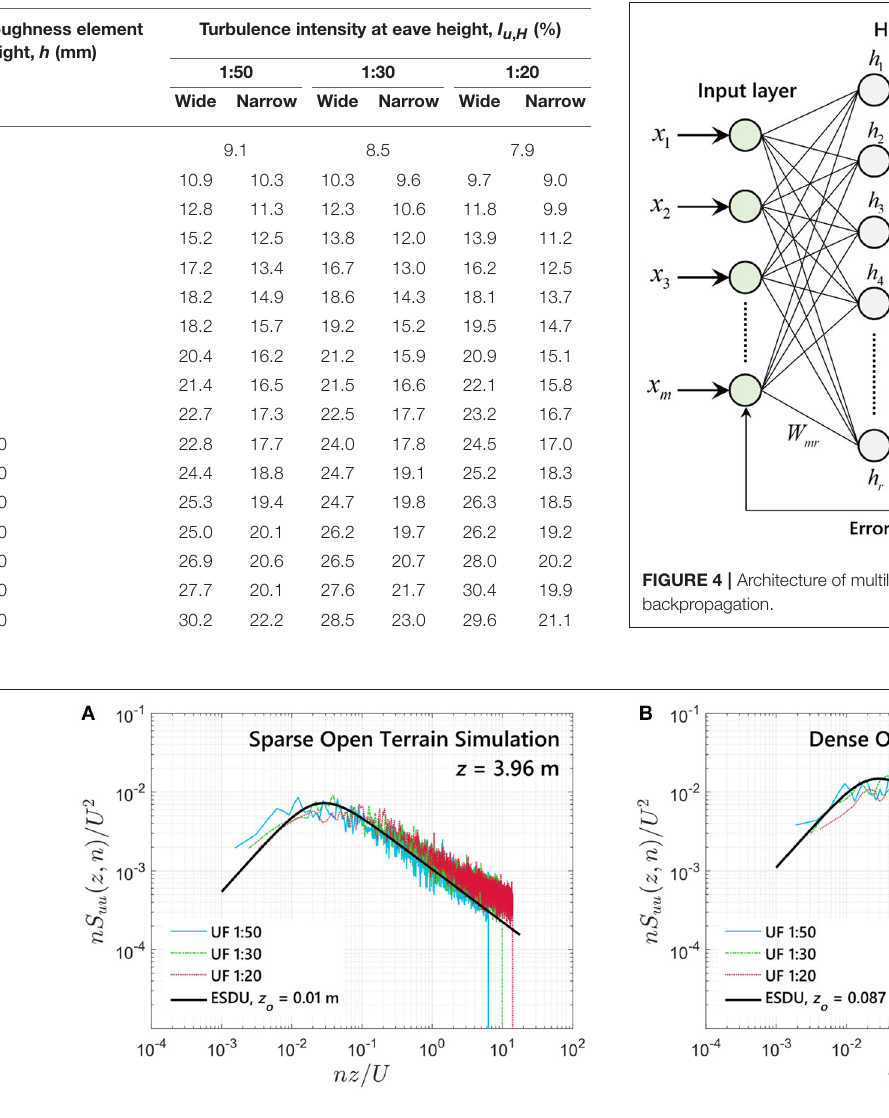
FIGURE 3 | Longitudinal turbulence spectra; at eave height ( z = 3.96m full-scale); of the freestream measured at the center of the test section; with the building model removed. The simulation of the two terrains is achieved for roughness element heights of 40mm (sparse open) and 100mm (dense open) in a wide edge windward